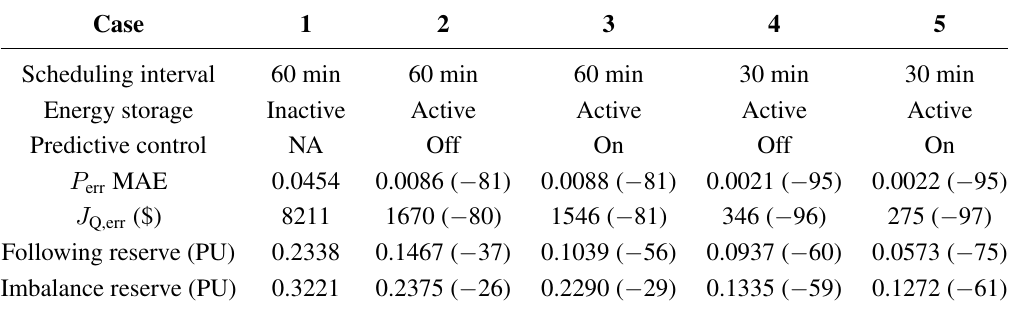
Table 1. Simulation results over approximately one week (888 10-min samples). Percent change from the base case, Case 1, is shown in parenthesis. MAE: mean absolute